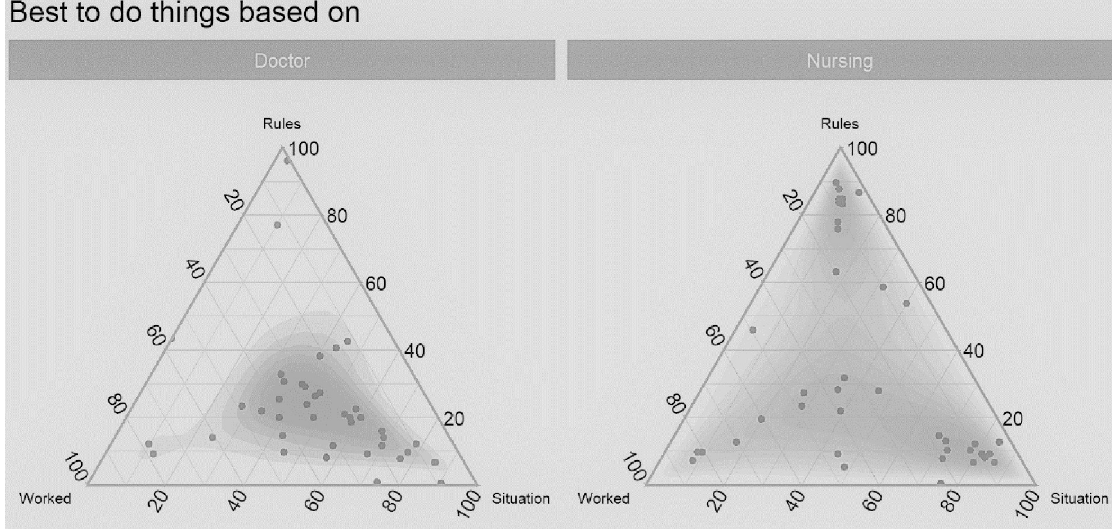
Fig 2. Doctors’ and nurses’ perceptions of appropriate